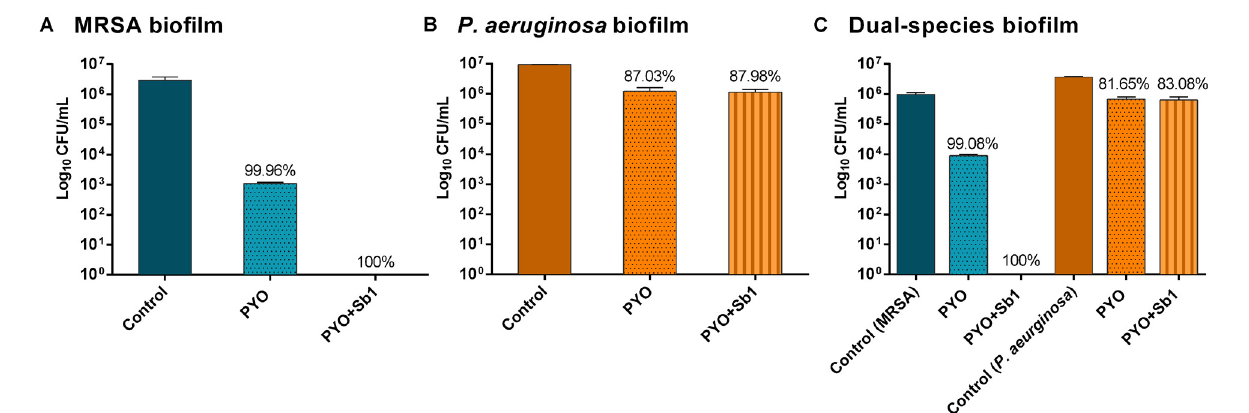
FIGURE 5 | Effect of PYO and Sb-1 phage preparations on viability of biofilm-embedded mono and mix bacteria populations. S. aureus/P. aeruginosa mono- (A,B) and dual-species (C) biofilms formed on porous glass beads were exposed to phages. Data are reported as log10 CFUs/mL mean ± standard deviation of at least three independent experiments. Percent of cell reduction of treated samples compared to untreated samples was calculated as: percent reduction = [(A–B)/A] × 100, where A is the mean number of viable bacteria of the growth control and B is the mean number of viable bacteria after exposure to PYO or PYO+Sb-1.